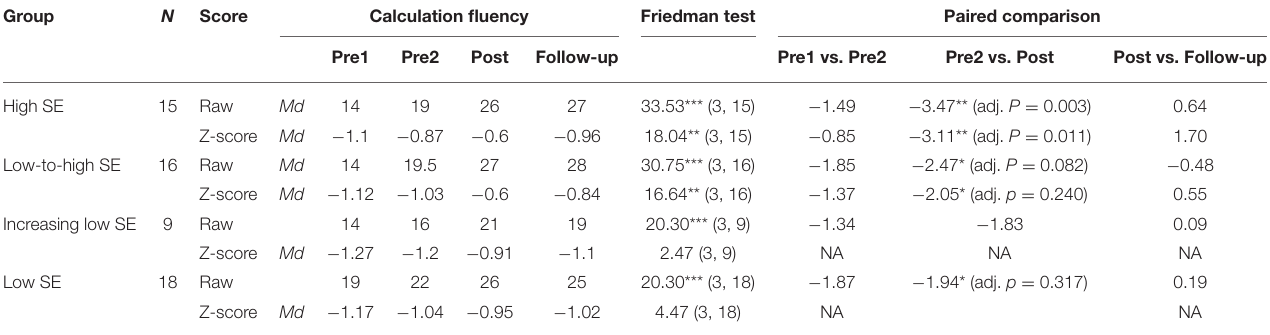
TABLE 6 | Changes in calculation fluency among children with different self-efficacy profile (RQ3). Group